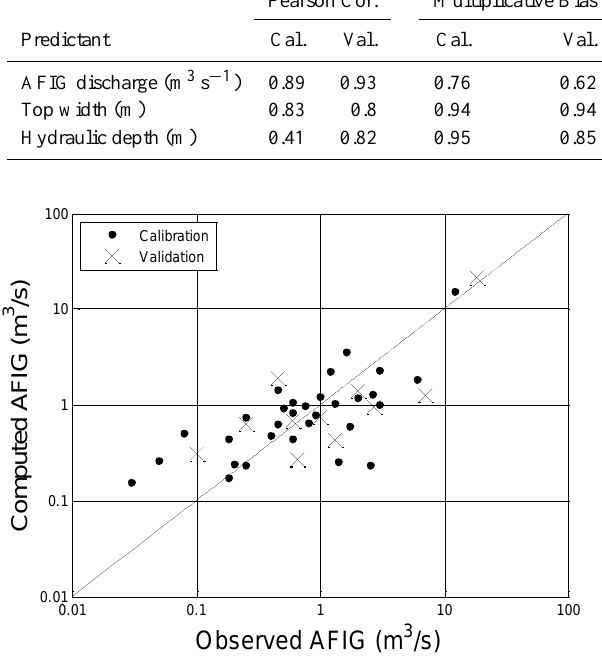
Table 4. Performance evaluation and regression equations for AFIG discharge, top width and Hydraulic depth. Pearson Cor.